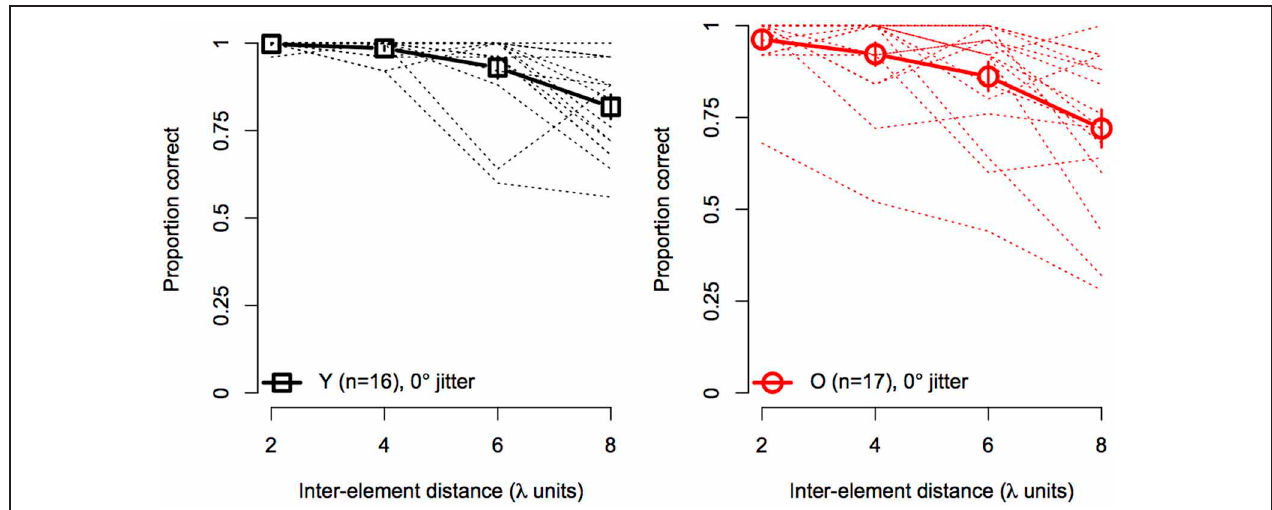
FIGURE 4 | Experiment 1 results: contour discrimination accuracy is shown a function of inter-element distance for contours with 0 ◦ orientation jitter (collinear). Dashed lines show individual subjects’ data, solid lines show mean accuracy, and error bars represent ± 1 SEM.